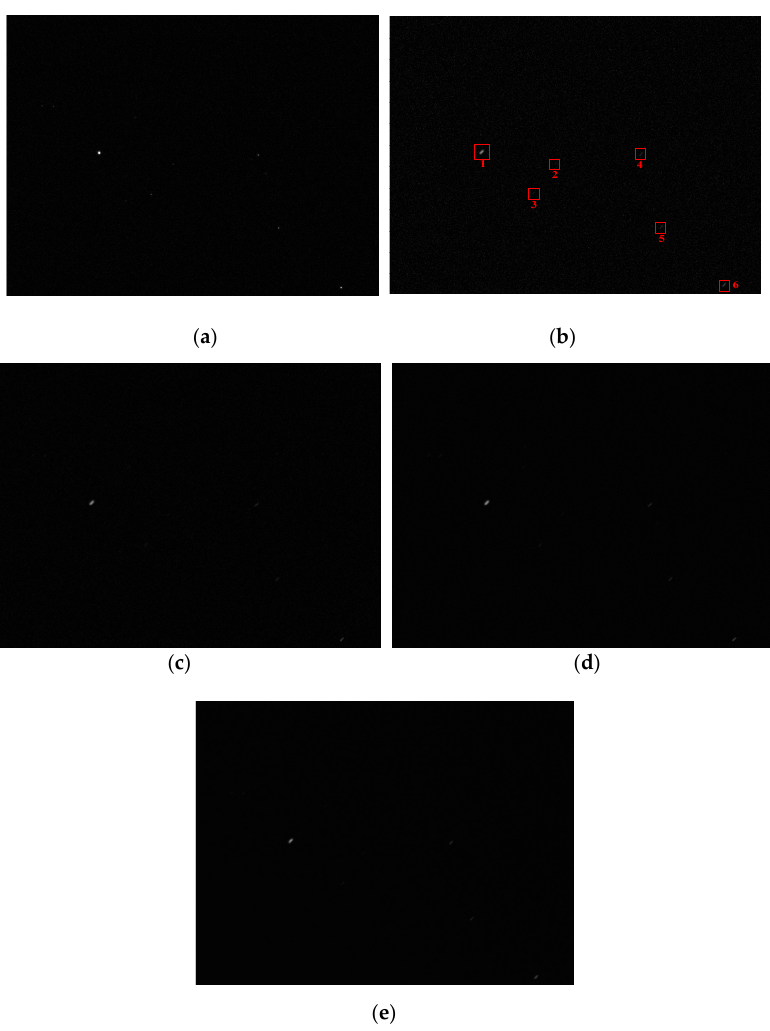
Figure 12. Denoised star images with different methods. ( a ) True star image; ( b ) blurred star image; ( c ) denoised star image with Bayes Shrink; ( d ) denoised star image with open operation; ( e ) denoised star image with the proposed algorithm.